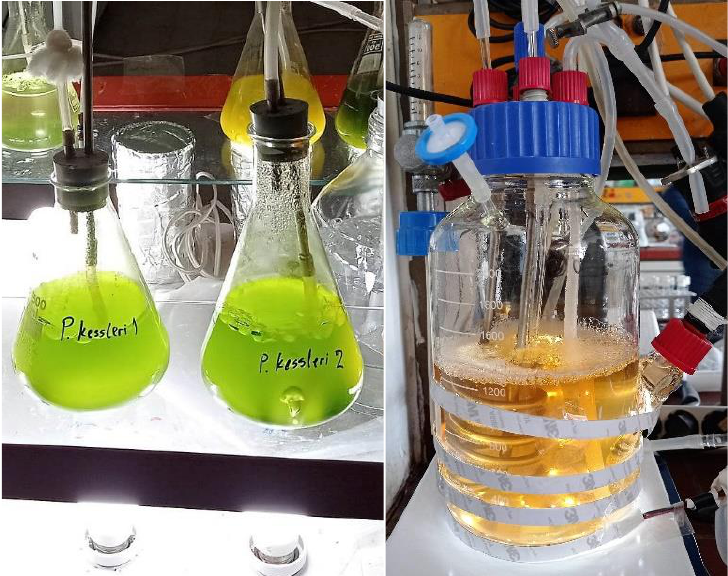
Figure 1. Experimental setup used in this study for the cultivation of Parachlorella kessleri in Erlen- meyer flasks ( left ) and in cylindrical photobioreactors ( right ). Table 1. Description of the experiments used in proposed model training and